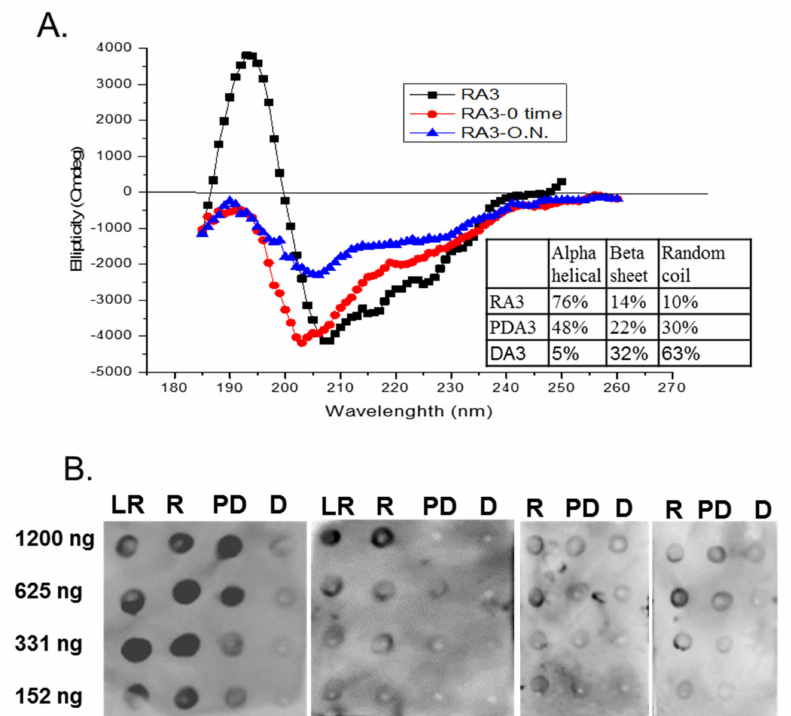
Figure 3. ( A ) Circular dichroism (CD) spectra and IgE spot blots analysis of varying concentrations of light roast (LR), roasted (R), partially denatured (PD) and fully denatured (D) Ara h 3. The percentages of the secondary structure elements are shown in the inset of; ( B ) Equal and decreasing amounts (shown on the left of the blots in nanograms, ng) of each, LR, R, PD and fully denatured (D) Ara h 3, are spotted onto nitrocellulose membranes and incubated with 1:10 dilution of four patients’ sera with history of anaphylaxis to peanut. PDA3 was obtained by incubating with DTT for 5–10 min (0 time, RA-0 time) and DA3 was obtained by incubation with DTT over night (O.N.,